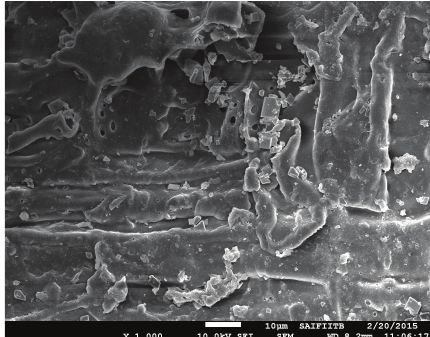
Figure 6: EDS spectra of lead ion loaded CCRWSD.